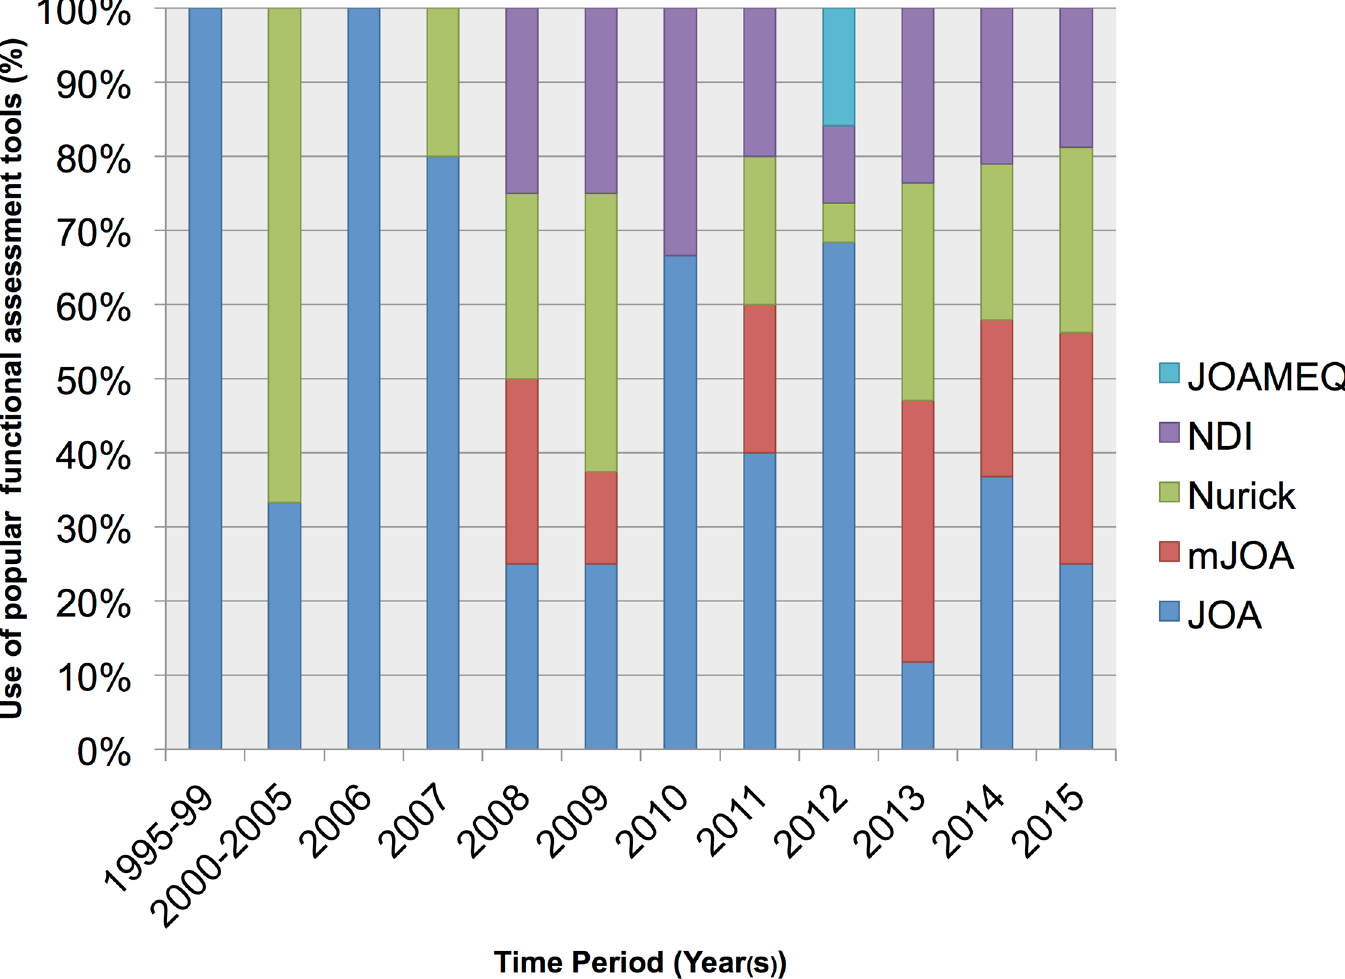
Fig 3. Variation in chosen functional outcomes overtime. Each bar represents 100%. The use of the most prevalent outcome measures (JOA, Nurick, NDI, mJOA, JOACMEQ) are reported as percentages for each time period.